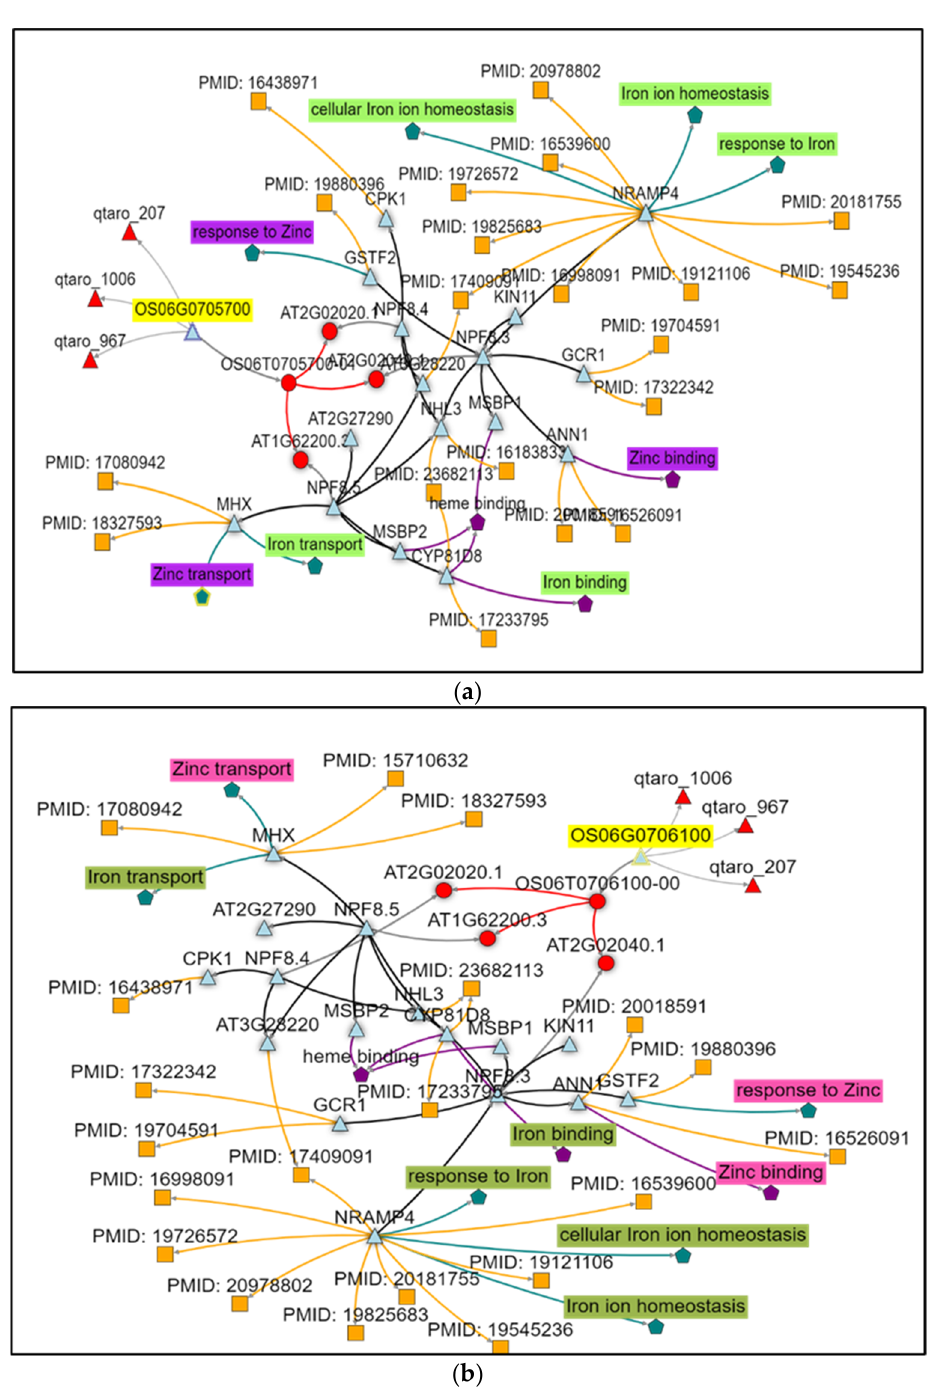
Figure 6. ( a ) Network analysis of candidate gene (Os06g0705700) in a major QTL qZnPR.6.2 using Knetminer analysis; ( b ) Network analysis of candidate gene (Os06g0706100) in a major QTL qZnPR.6.2 using Knetminer analysis.